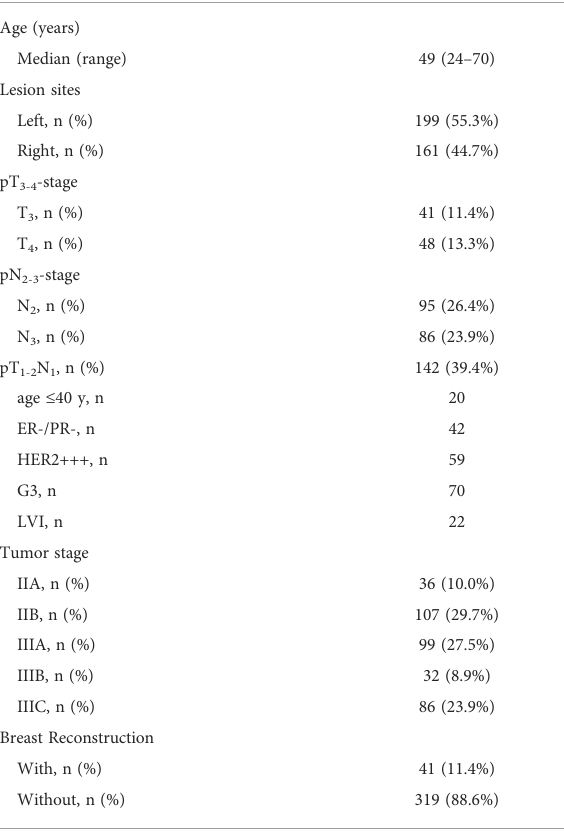
TABLE 2 Patient